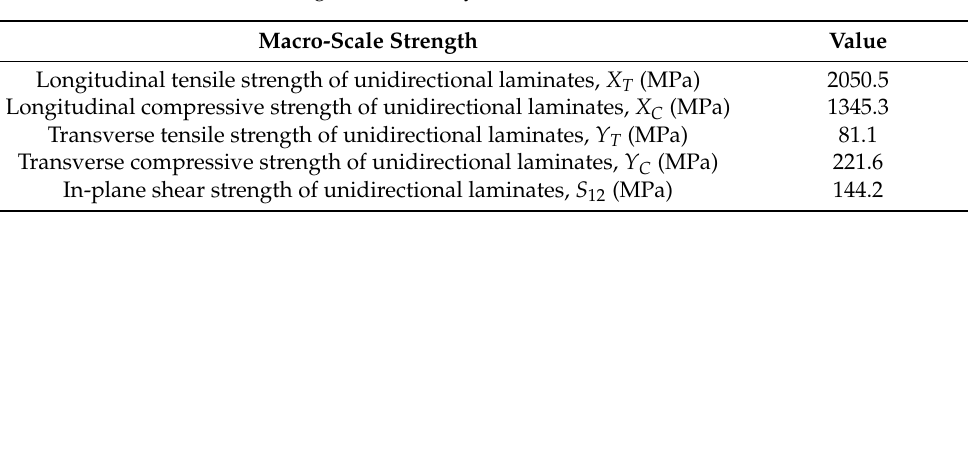
Table 3. Tested macro-scale strengths of T300/Cycom970 unidirectional